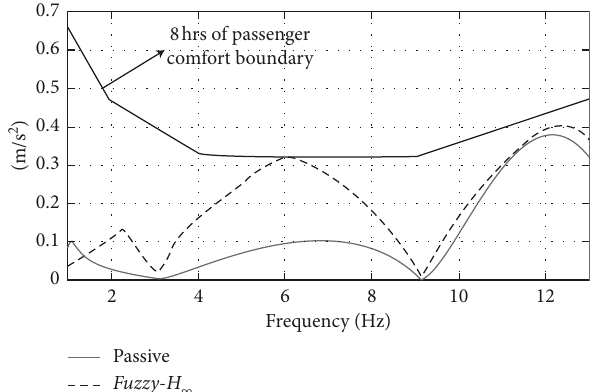
Figure 23: Sprung mass centre-of-gravity acceleration ( € Z upper wide black line represents the boundary limits to maintain a passenger comfort situation for 8hrs [28].